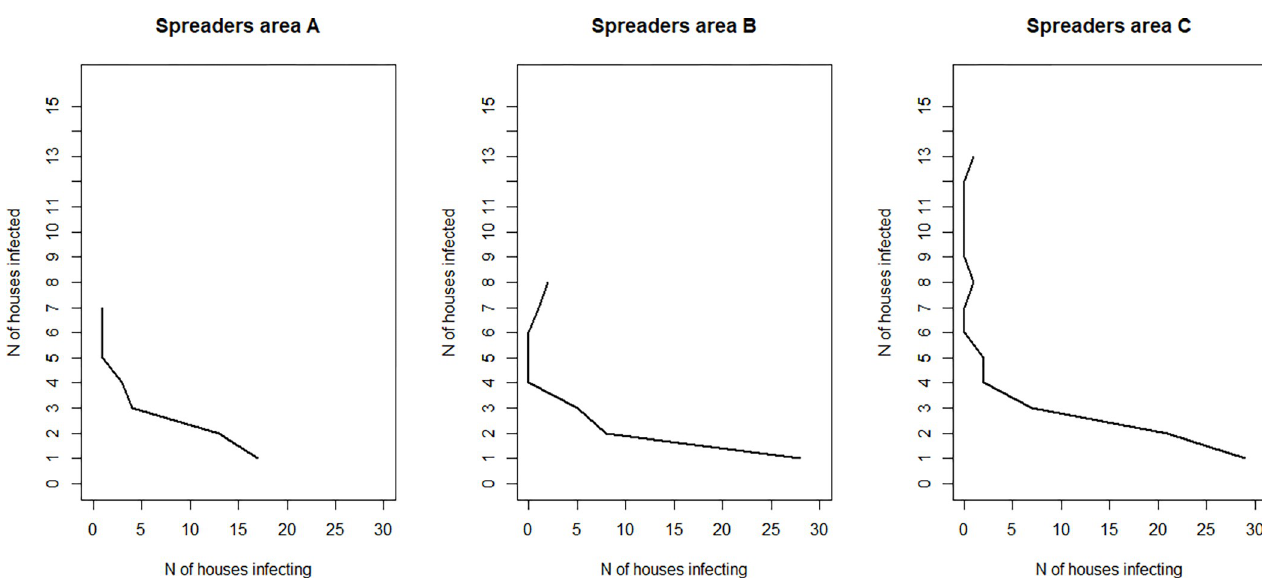
Fig 2. Spreaders for each focal area obtained by MALSWOTS for the whole study period. Each plot shows the number of new houses (from 1 to 15 houses in bins of 1) predicted to have been infected by x original houses. For example, 14 houses are likely to have infected 2 other houses each in Focal area A.